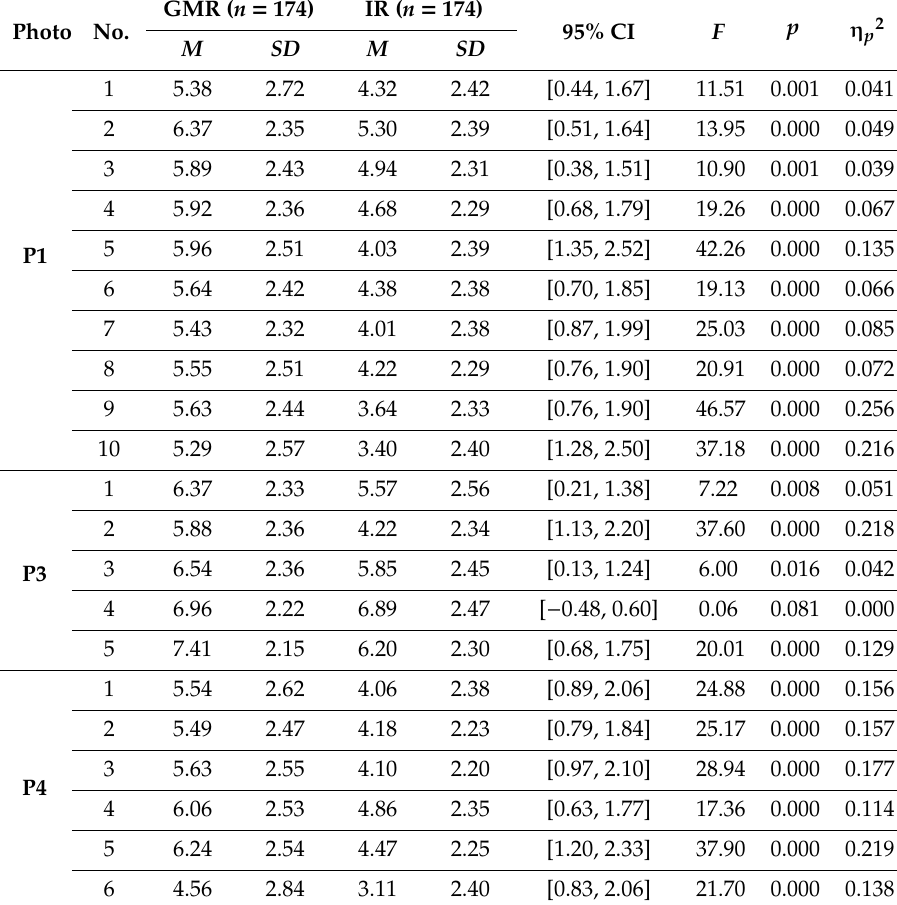
Table 6. Comparisons between IR and GMR from Study Ic ( n = 136). Photo No.